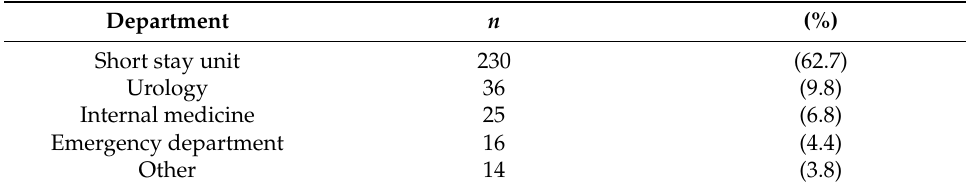
Table 2. Departments where APN patients were